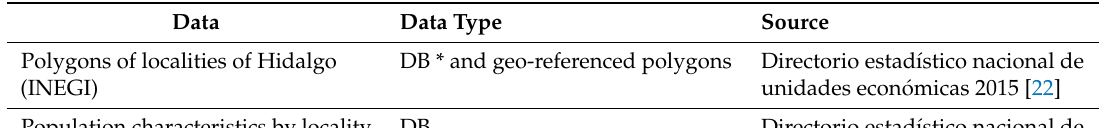
Table 2. Information sources for the study of the State of